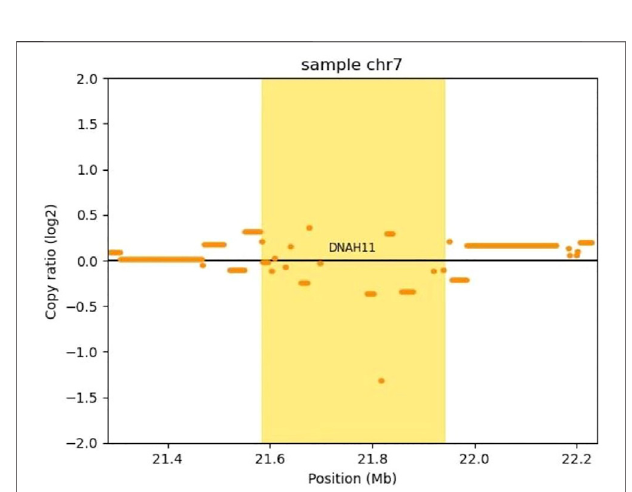
FIGURE 4 | Copy number analysis of the DNAH11 gene deletion by CNVkit.CNVkit,acommand-linetoolkitforcopynumberanalysis,wasapplied in our CNV analysis (version 0.9.9). It is designed for use with hybrid capture, including both whole-exome and custom target panels, and short-read sequencing platforms such as Illumina and Ion torrent. We built a reference from normal samples according to our exome ’ s capture positions, detected a CNV with log2 (copy ratio) < − 1 in DNAH11 gene (bright yellow block), which means one copy loss.